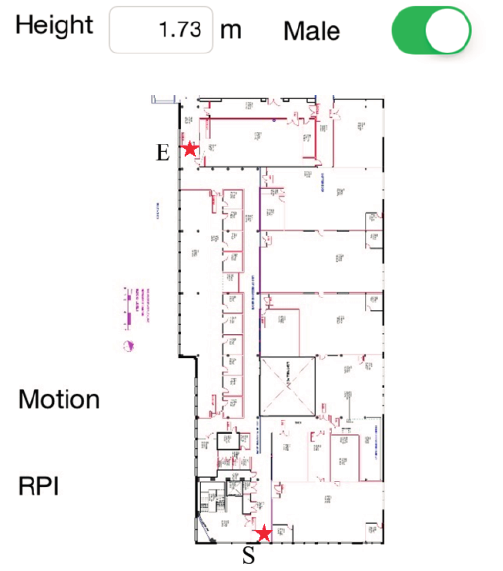
Figure 7. Application